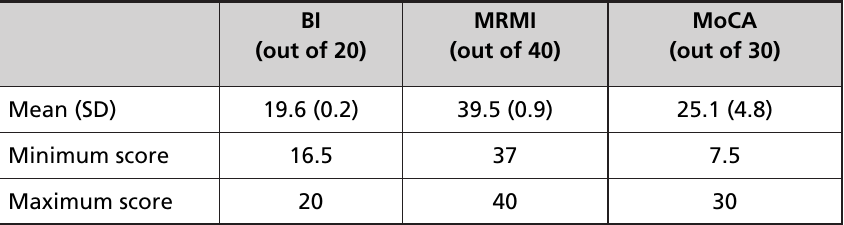
Figure I: Co-morbidities among stroke Table 1: Stroke survivors’ activities of daily living, mobility and cognitive ability (n = 72)